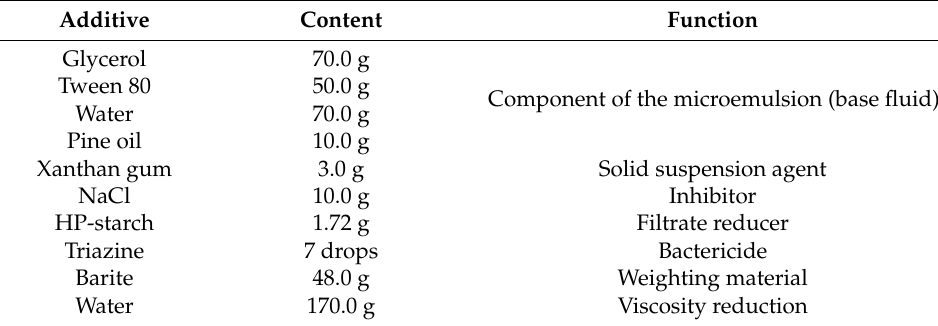
Table 1. Formulation of the microemulsion ‐ based drilling fluid.